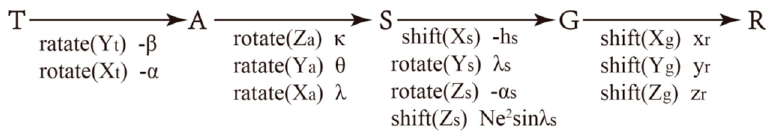
Figure 5. Coordinate transformation process.